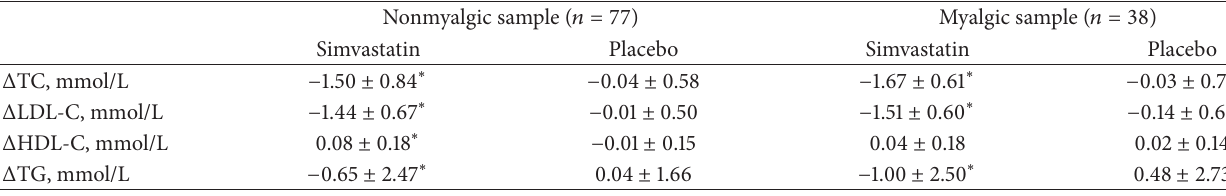
Table 2: Plasma lipid changes by drug assignment and myalgia status a,b .